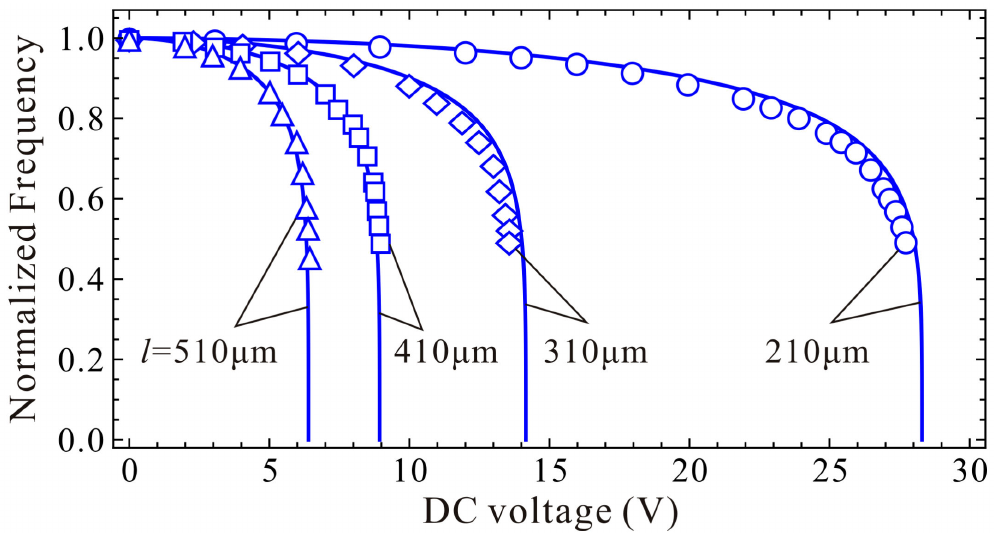
Figure 8. Comparison of the normalized fundamental frequencies between experiment result [39] (discrete point) and presented calculation with high-order differential quadrature method (DQM) using 11 grid points (solid